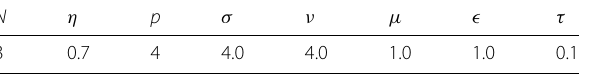
Table 4 Parameters related to experiments